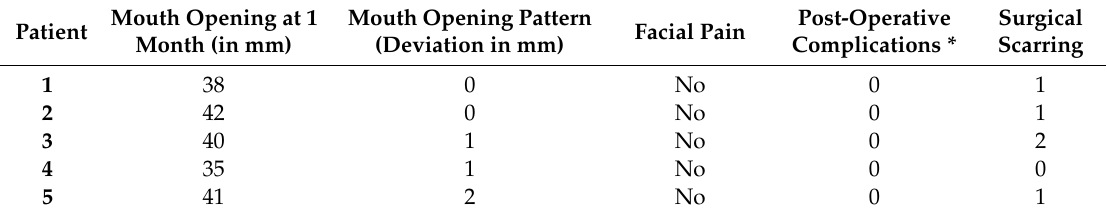
Table 6. Post-operative results and